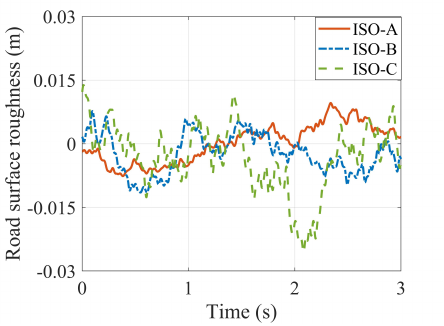
Figure 4. The road displacement spectrums.